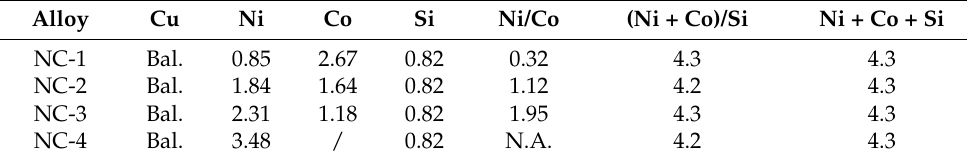
Table 1. Testing compositions of the Cu-Ni-Co-Si alloys, wt.%.